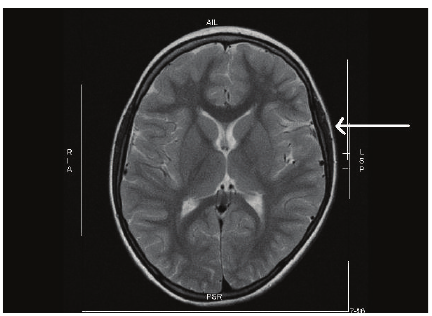
Figure 5: MRT of the brain (M.H.) at 7 years of age (2011). Depression of the left temporal brain after traumatic molding by a “long pelvis” [2] during parturition is still visible (arrow) (1.5-Tesla, head coil array, T2w TSE